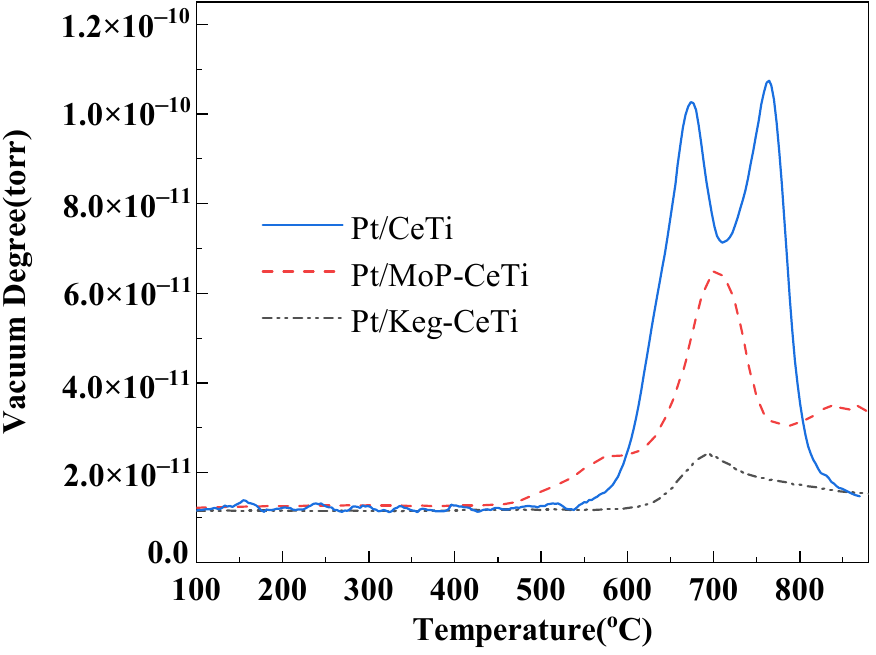
Figure 6. SO 2 -TPD of Pt/MoP-CeTi, Pt/Keg-CeTi, and Pt/CeTi after exposure to 1000 ppm of SO 2 with 16% O 2 in Ar atmosphere for 1 h at 250 °C. Table 2. Surface atomic concentration and atomic ratio of Pt/CeTi, Pt/Keg-CeTi, and Pt/MoP- CeTi